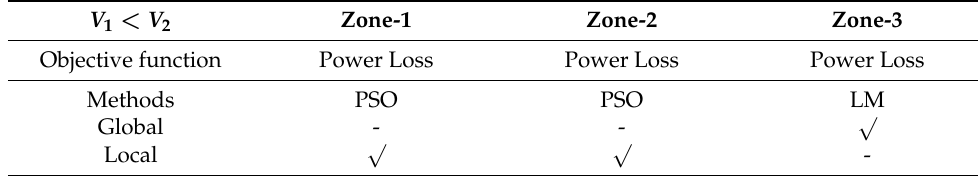
Table 1. Optimization methods based on the power regions. V 1 < V 2 Zone-1 Zone-2 Zone-3 Objective function Power Loss Power Loss Power Loss Methods